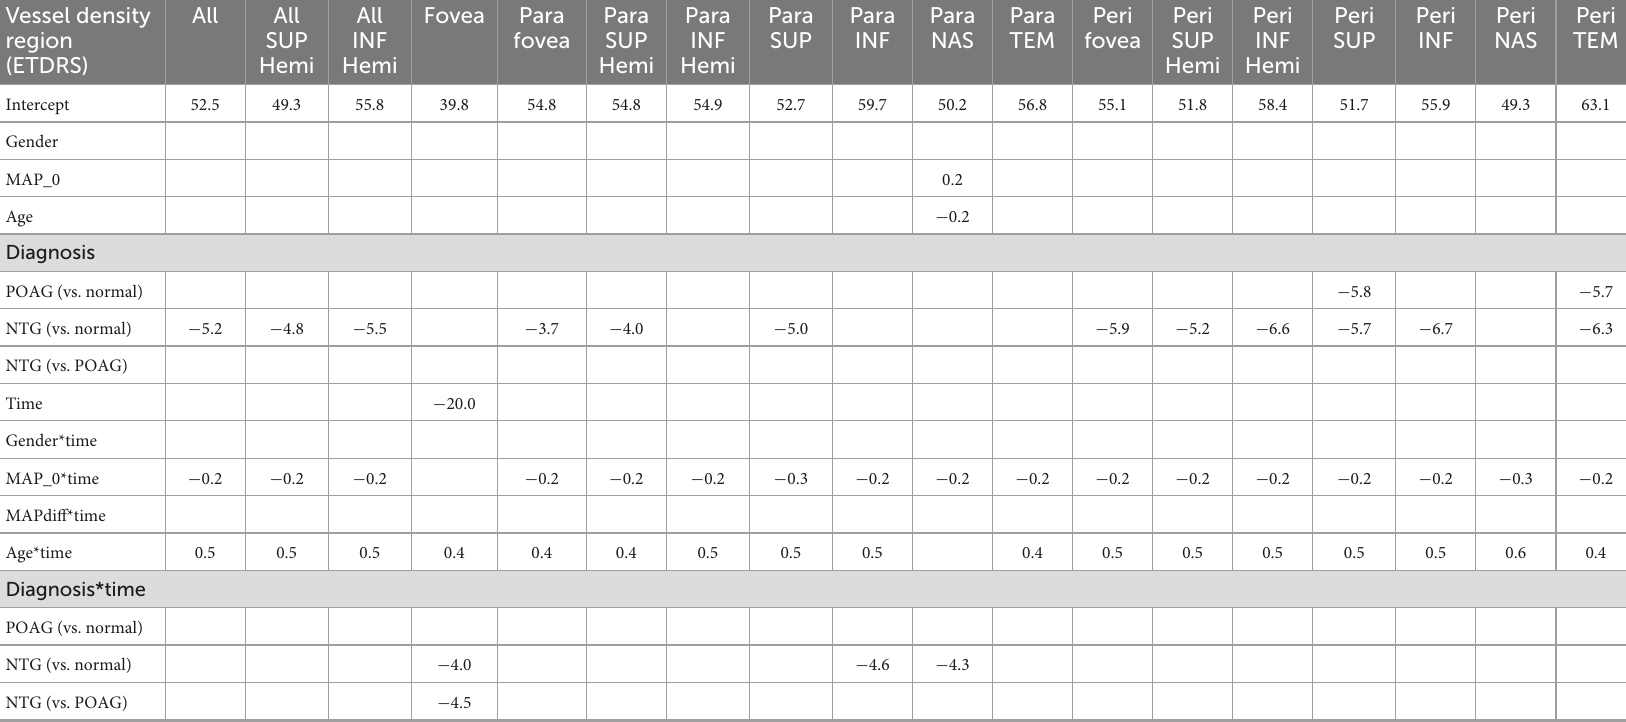
TABLE 5 Macular deep [inner plexiform layer (IPL)-outer plexiform layer (OPL)] vascular plexus vessel density (OCTA) adjusted linear mixed model estimates